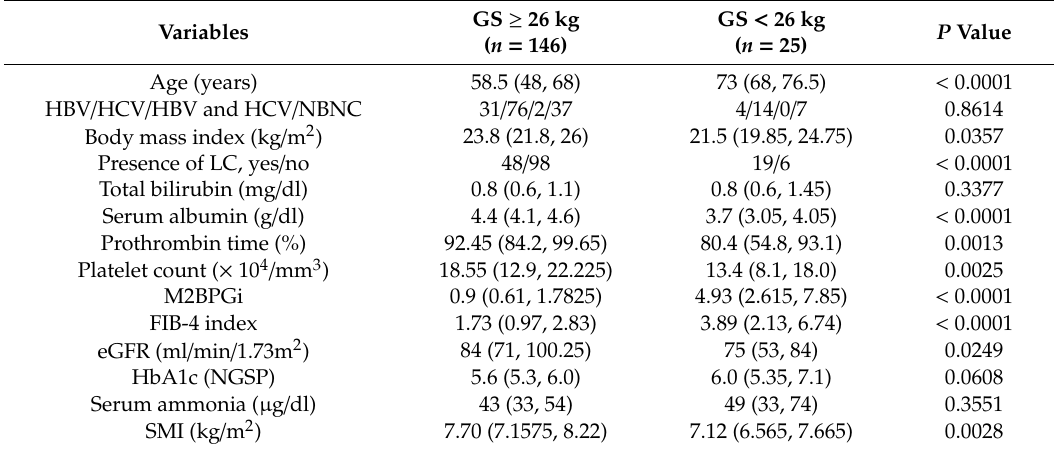
Table 2. Univariate analyses of factors linked to grip strength (GS) < 26 kg in male.